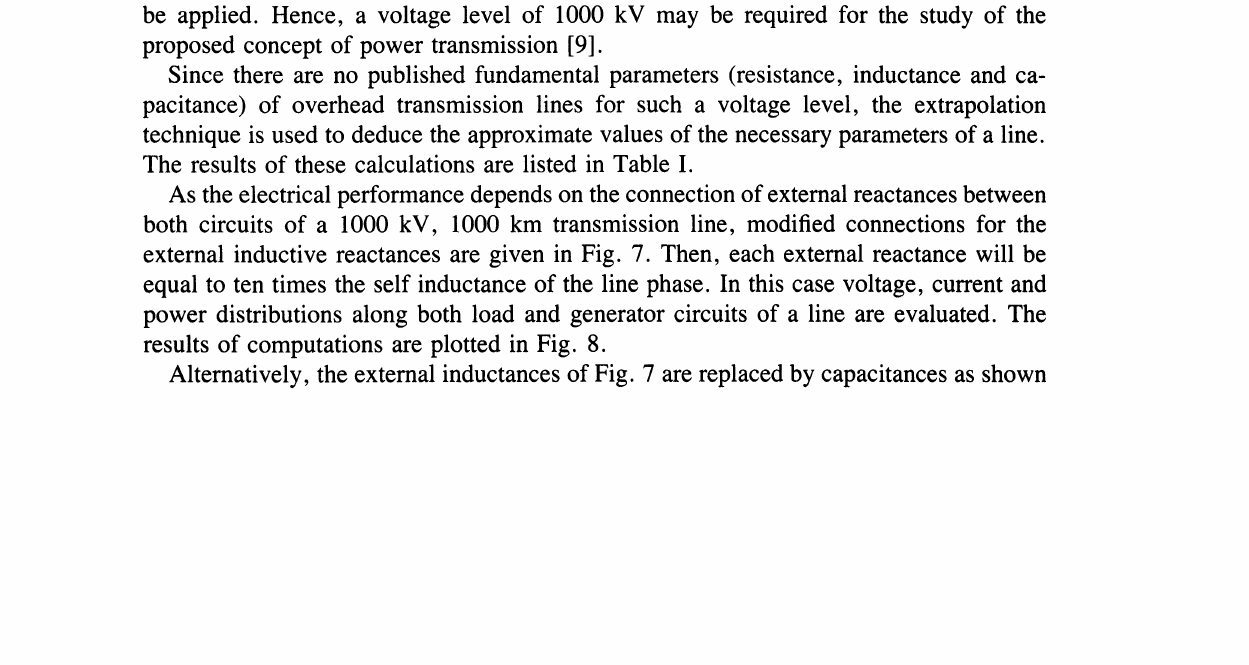
FIGURE 6 The voltage distribution along the proposed 500 kV, 1000 km transmission line: (1) reactor at receiving end (2) reactor at middle point (3) without reactors as Fig. lc (4) ordinary double circuit